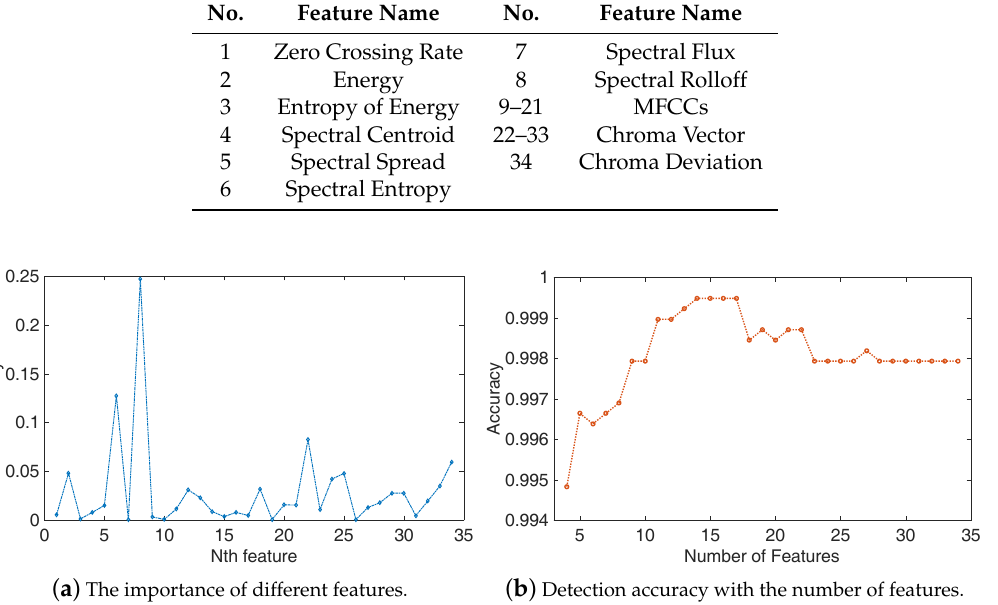
Table 3. The features extracted by pyAudioAnalysis constitute the original feature space. No. No.